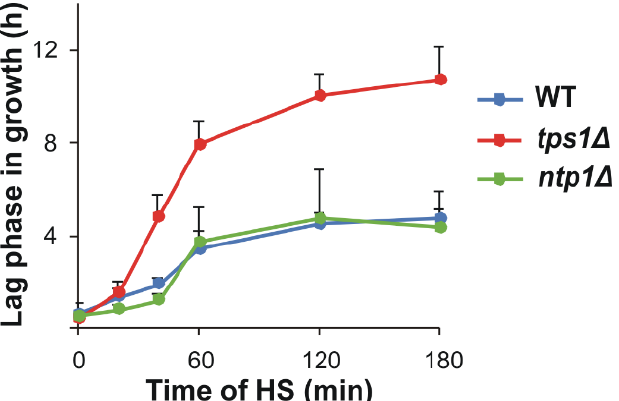
Figure 1. Alteration of lag period due to heat stress (HS). Yeast cells were heat-stressed at 40 °C for 0–180 min. Data are presented as mean ± SD, n = 3 (independent experiments); for significance values, see Table S1. WT, wild-type; tps1 ∆ , trehalose-deficient; ntp1 ∆ , trehalase-deficient S. pombe